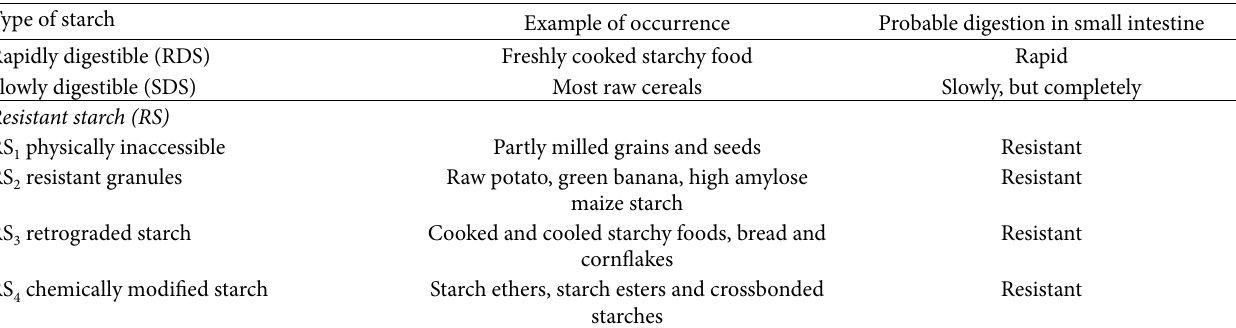
Table 1: Classification of starch